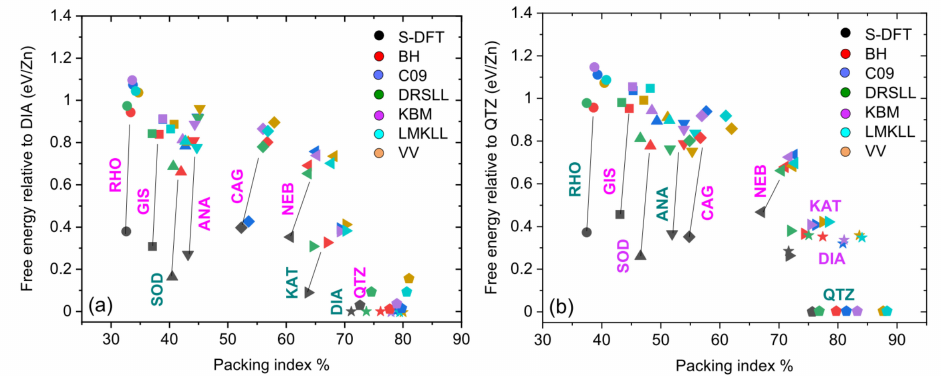
Figure A1. Relative energies for S-DFT (black dots) and vdW-DF (colored symbols) calculations as a function of the packing index. ( a ) Topologies with the HMeIm ligand. ( b ) Topologies with the HEtIm ligand. The green labels denote the structures synthesized experimentally. The vdW-DF considered are DRSLL [32,33], LMKLL [34], KBM [35], C09 [36], BH [20] and VV [37]. Table A1. Lattice parameters a, b and c of the unit cell in Å (first three rows) and angles α , β and γ in degrees (fourth row) at 0 Kelvin. The vdW-DF was calculated using the BH functional [20]. The measured values are from [15]. S-DFT vdW-DF Measured HMeIm sequence